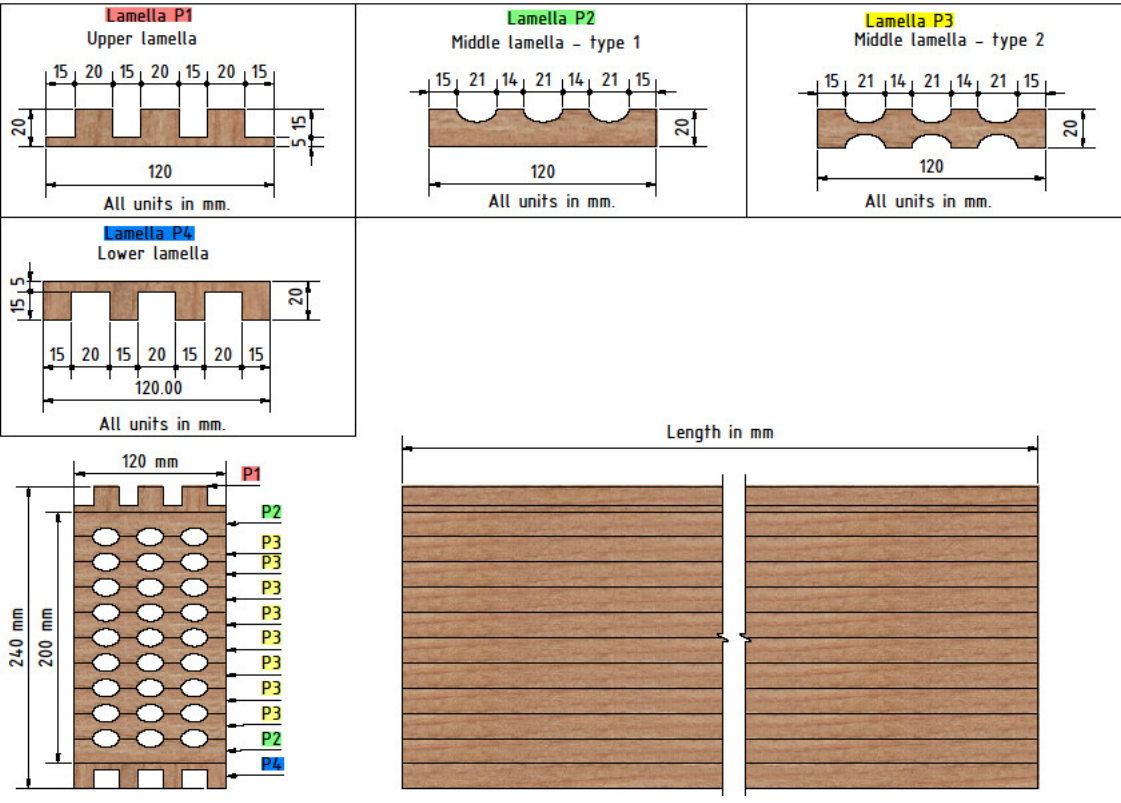
Figure 5. Lamellae and assembled specimen with elliptical cavities.